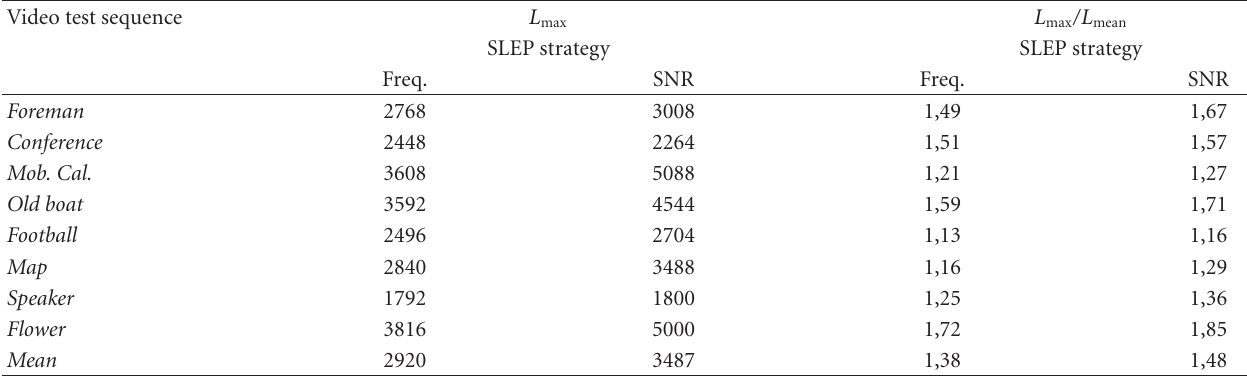
Table 1: Comparison of Wyner-ZIV image characteristics for SNR and frequency scalability for di ff erent test images ( L max = maximum slices length, in bits; L mean = mean slices length, in